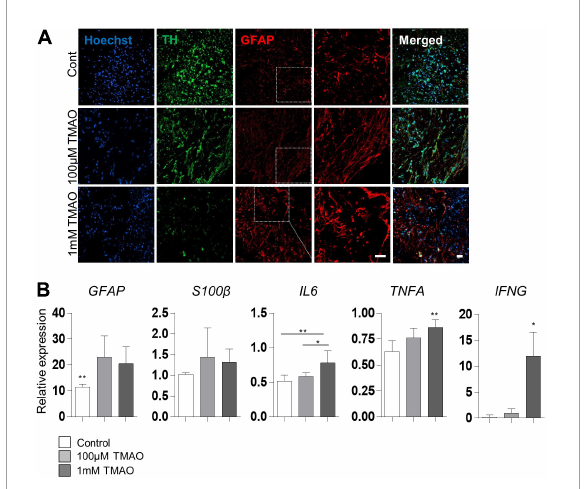
FIGURE4 Astrocyte activations in trimethylamine N -oxide (TMAO)-treated midbrain organoids. (A) Representative IF images showing the TH-positive dopaminergic neurons and glial fibrillary acidic protein (GFAP)-positive astrocytes in indicated organoids. Hoechst was used for counter nuclei staining. (B) Relative mRNA expression level of GFAP and mRNA expression level of activation astrocytic markers, GFAP, S100 β , IL6, TNFA, and IFNA in indicated organoids (8WMs). Data are AVE ± SD [ P < 0.05(*), P < 0.01(**)]. (Scale bar = 20 µ